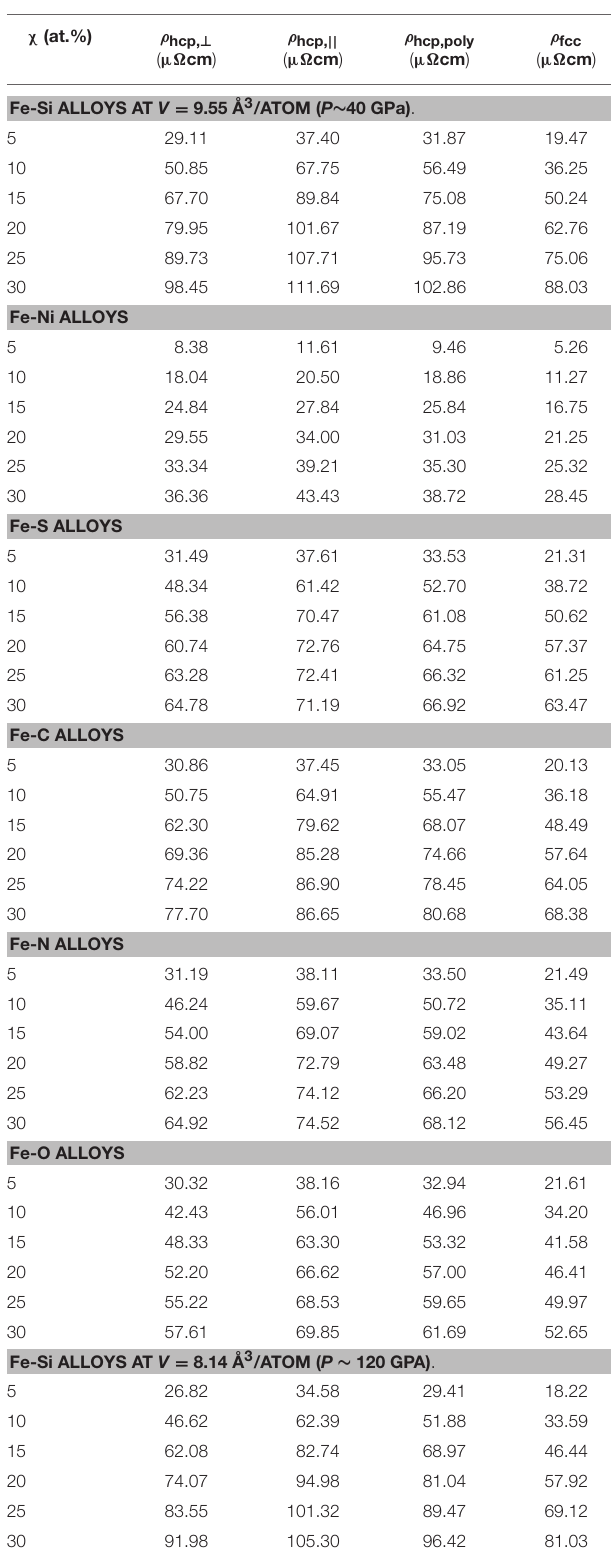
TABLE 1 | Impurity resistivity of Fe-alloys at zero